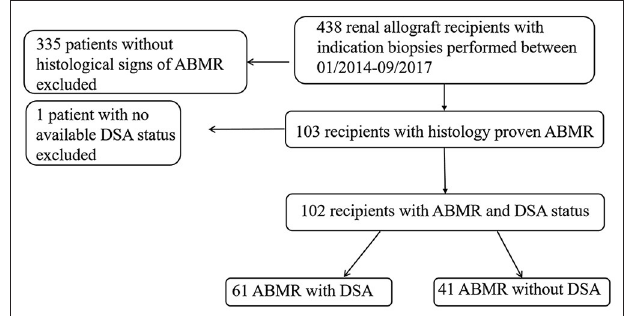
FIGURE 1 | Study population flow chart. ABMR, antibody-mediated rejection; DSA, donor-specific antibody.